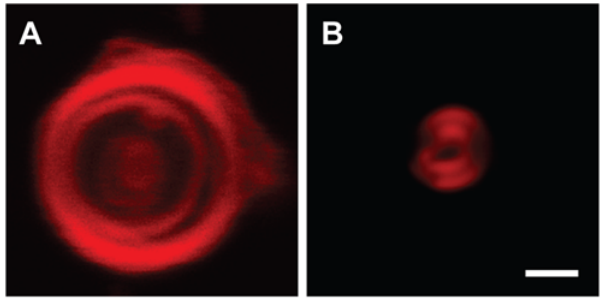
Figure 4. Confocal images of oleate and POPC vesicles prepared by extrusion-dialysis. (A) Confocal image of a multi- lamellar oleate vesicle after extrusion-dialysis (0.2 mol % Rh-DHPE, in 0.2 M Na-bicine, pH 8.5). (B) Confocal image of a multilamellar POPC vesicle after extrusion-dialysis (0.2 mol % Rh-DHPE, in 0.2 M Na-bicine, pH 8.5). Though the vesicle is small ( , 0.5 m m in radius, approaching the resolution limit of the confocal microscope), the image clearly indicates the presence of an internal membrane. Scale bar, 1 m